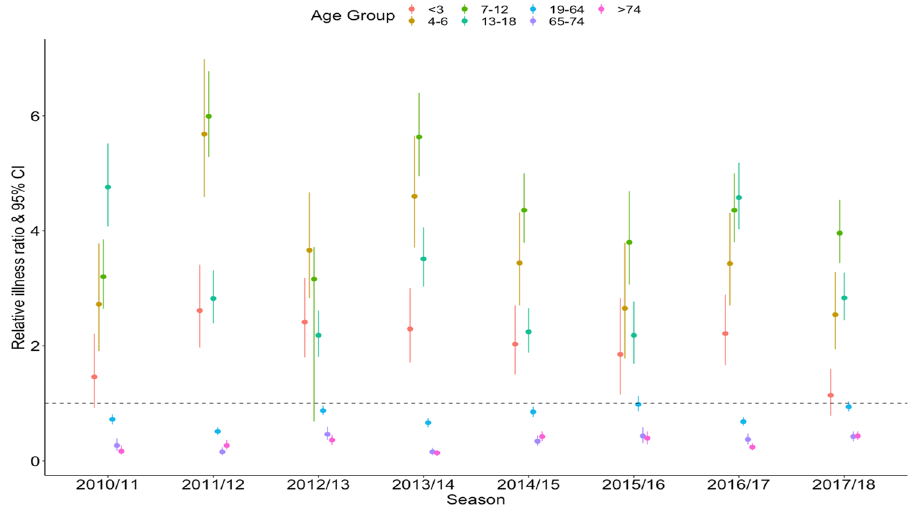
Figure 3. Relative illness ratio of